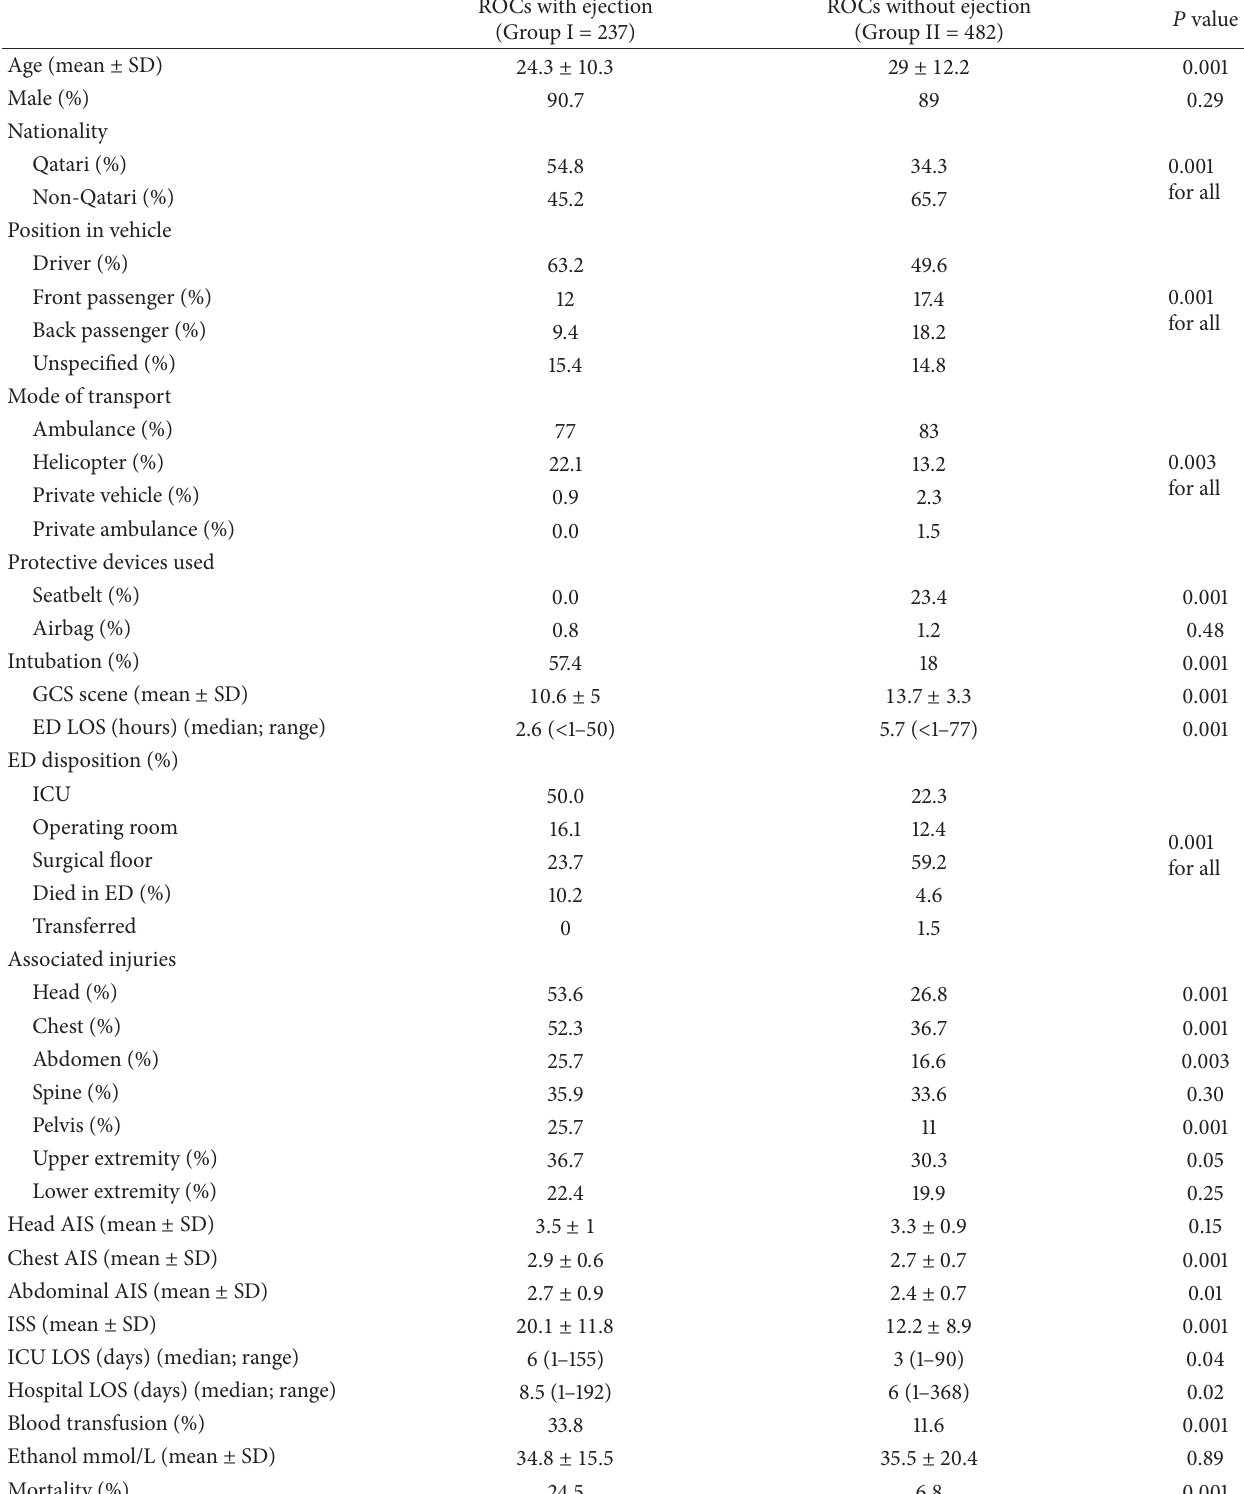
Table 2: Comparative analysis of rollover car crashes (ROCs) with and without